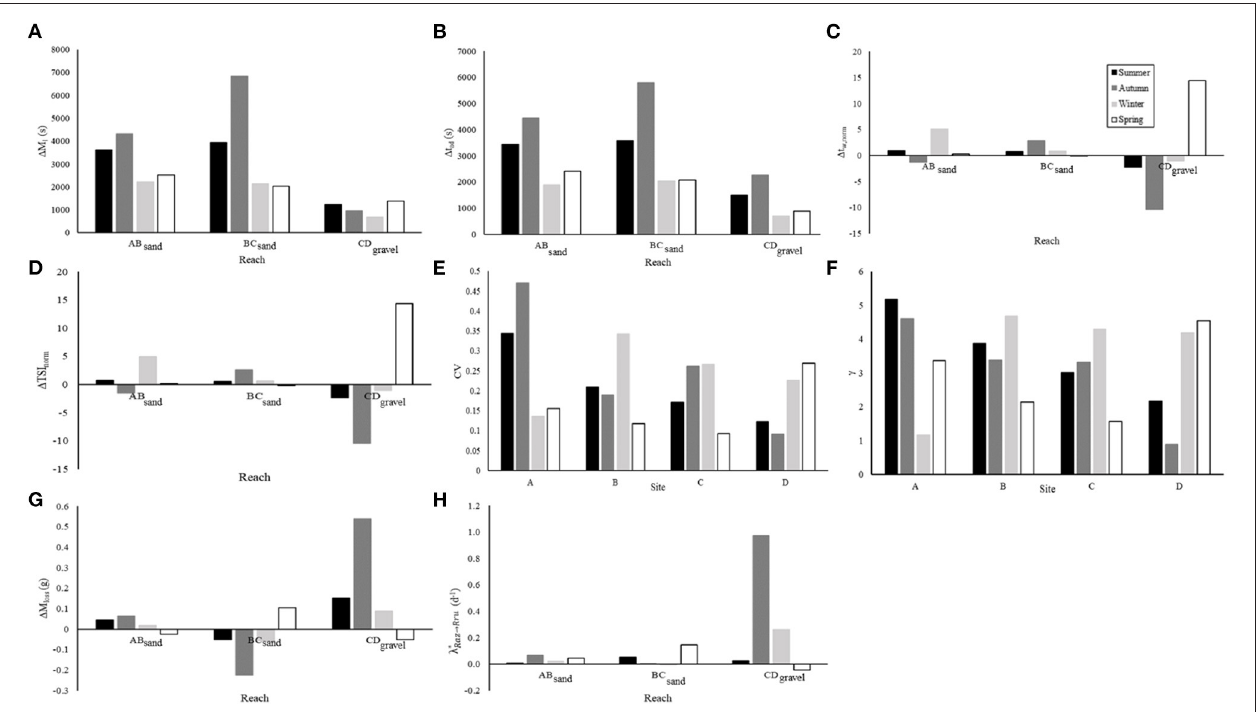
FIGURE 2 | The hydrological metrics of each experimental reach across all seasons, shown are (A) 1 M 1 (s), (B) 1 t ad (s), (C) 1 t w , norm , (D) 1 TSI norm , (G) 1 M loss , and (H) turnover of resazurin to resorufin as a proxy for aerobic microbial metabolism. Hydrological metrics of each experimental site across all seasons, shown are (E) coefficient of variance and (F) γ